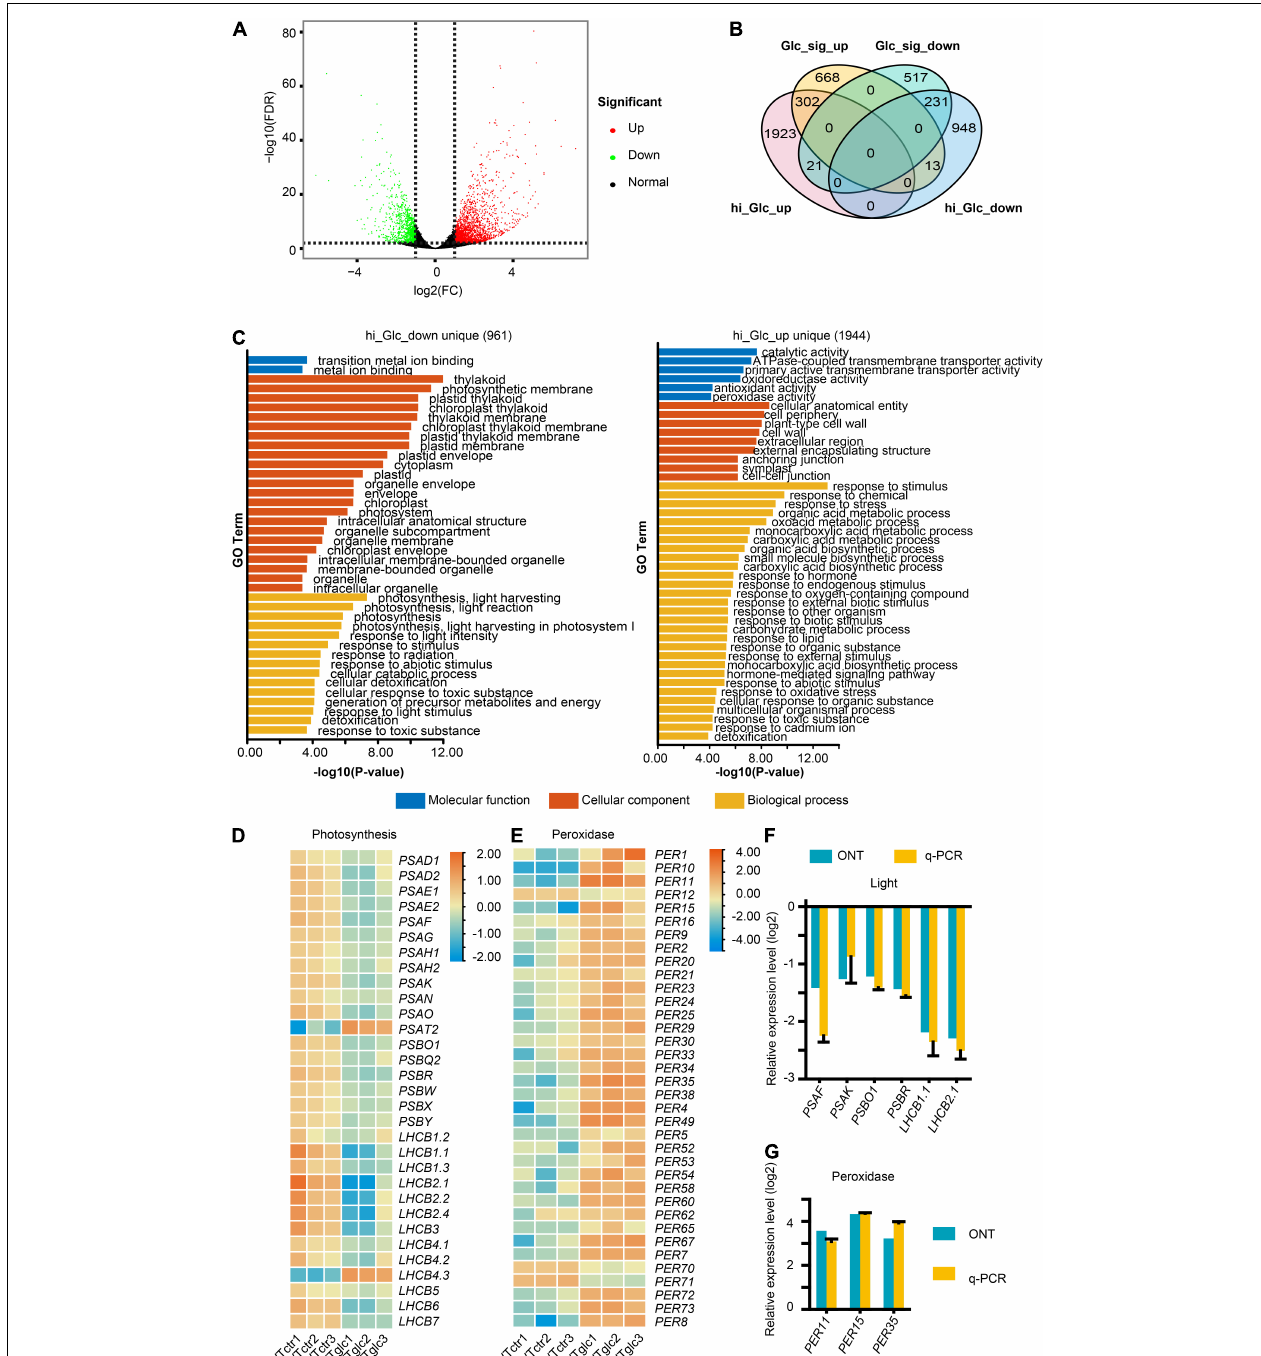
FIGURE 1 | High glucose suppresses the photosynthesis and activates the response to oxidative stress. (A) Volcano plot showing the differentially expressed genes (DEGs, | Log2FC| > 1, FDR < 0.01) regulated by 3% glucose treatment. (B) Venn diagram showing an overlap between DEGs regulated by 3% glucose and DEGs regulated by 15 mM glucose/glucose signaling (Xiong et al., 2013), hi_Glc_up, DEGs upregulated by 3% glucose, hi_Glc_down, DEGs downregulated by 3% glucose, Glc_sig_up, DEGs upregulated by 15 mM of glucose, Glc_sig_down, DEGs downregulated by 15 mM of glucose. (C) Gene ontology (GO) enrichment analysis of the DEGs uniquely upregulated by 3% glucose (1,944 genes) and uniquely downregulated by 3% glucose (961 genes) in comparison to DEGs. (D) Heatmap for the relative expression level of genes involved in photosynthesis. (E) Heatmap for the relative expression level of genes encoding peroxidases. (F) Nanopore sequencing (ONT) and quantitative real-time PCR (q-PCR) results for the relative expression of representative genes involved in photosynthesis. (G) Nanopore sequencing and q-PCR results for the relative expression of representative genes encoding peroxidases. Actin serves as an internal control for the q-PCR in both (F,G)